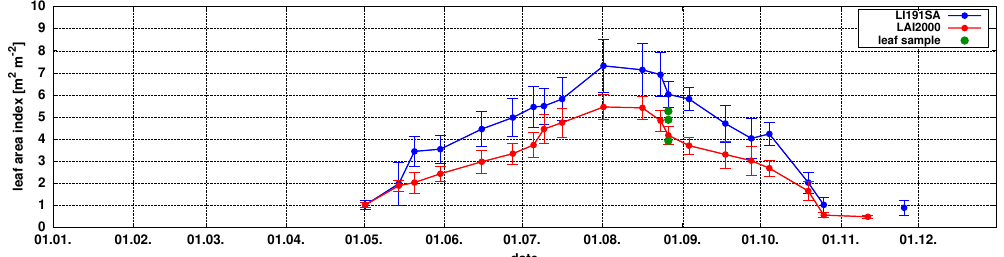
Figure 1. Means and standard deviations of leaf area index of the poplar SRC Reiffenhausen in 2013. Measurements of two optical devices: LI191SA calculated with constant extinction coefficient k = 0.5 and LAI2000 are shown. LAI values obtained by destructive harvesting at 26 August on three plots are shown as green dots.